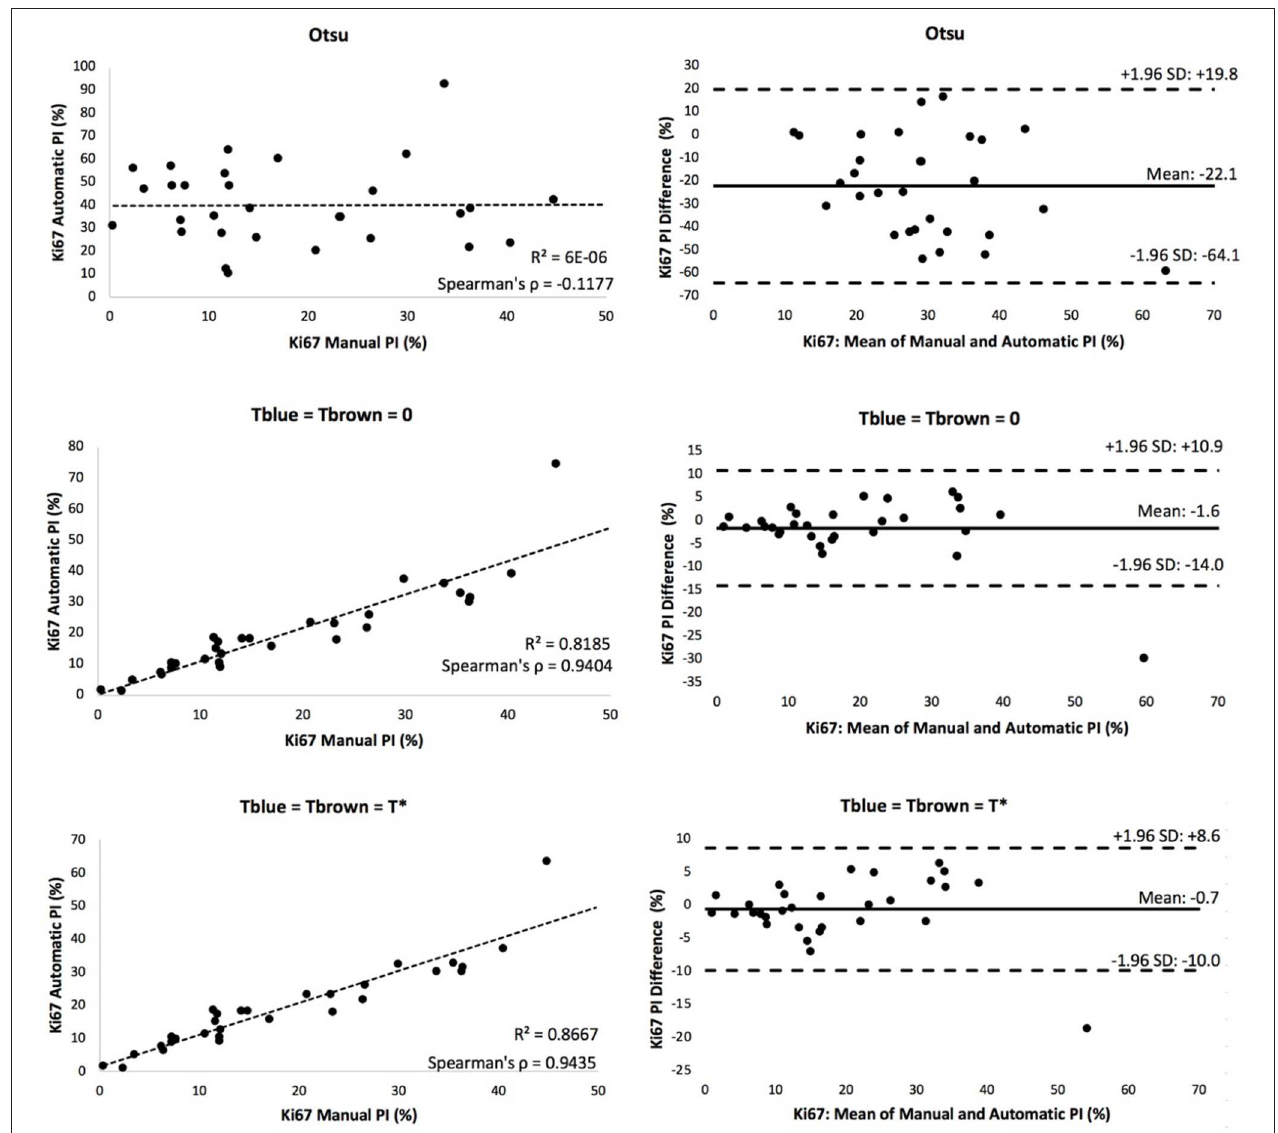
FIGURE 8 | Scatter plot ( left ) and Bland Altman plot ( right ) of each experimental thresholding condition’s PI results, with corresponding Spearman’s coefficient.